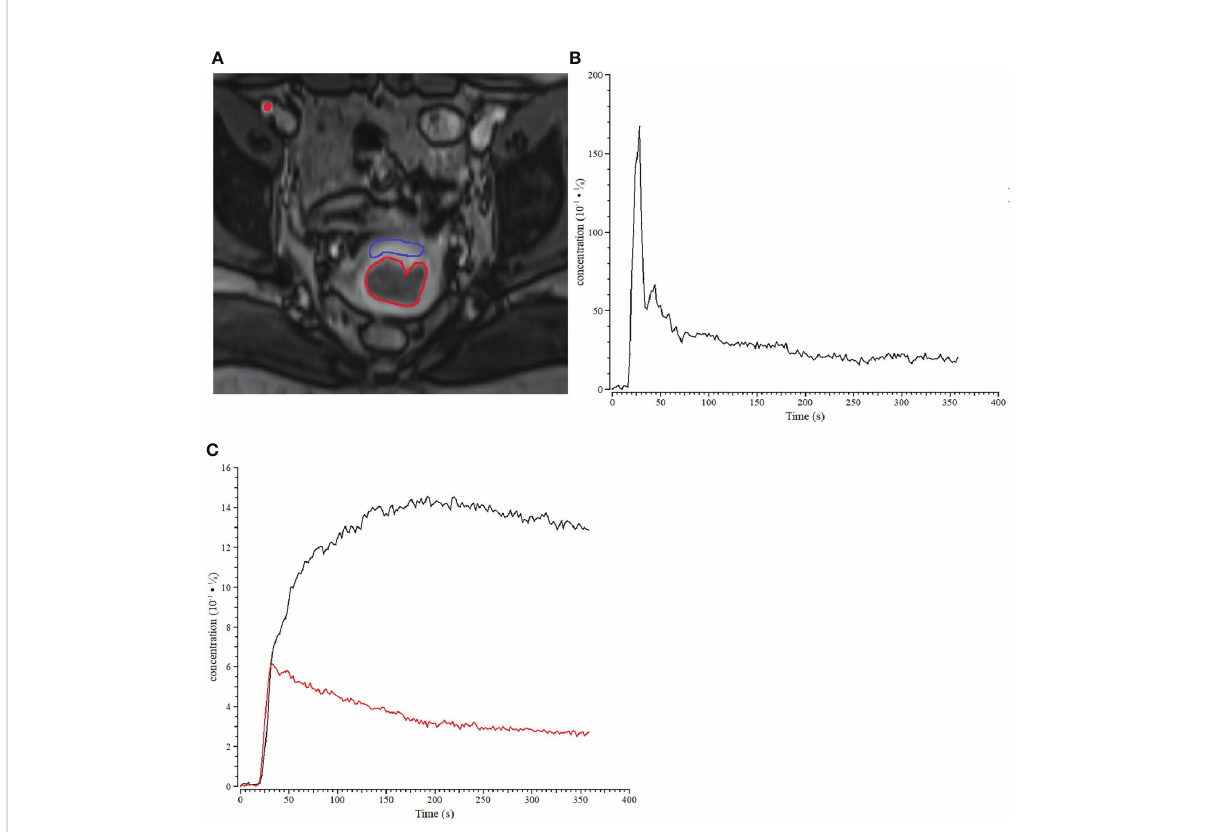
FIGURE 1 Example of a patient with stage IIb cervix cancer. (A) ROIs for cervix cancer (bred) and normal cervix tissue (blue) are shown for one slice of the DCE-MRI dataset, and the location within the iliac artery where the AIF was sampled was marked with a red dot. (B) Sample of AIF for the cervix cancer patient. (C) The concentration-time curve of cervix cancer (red) ROI and the normal tissue